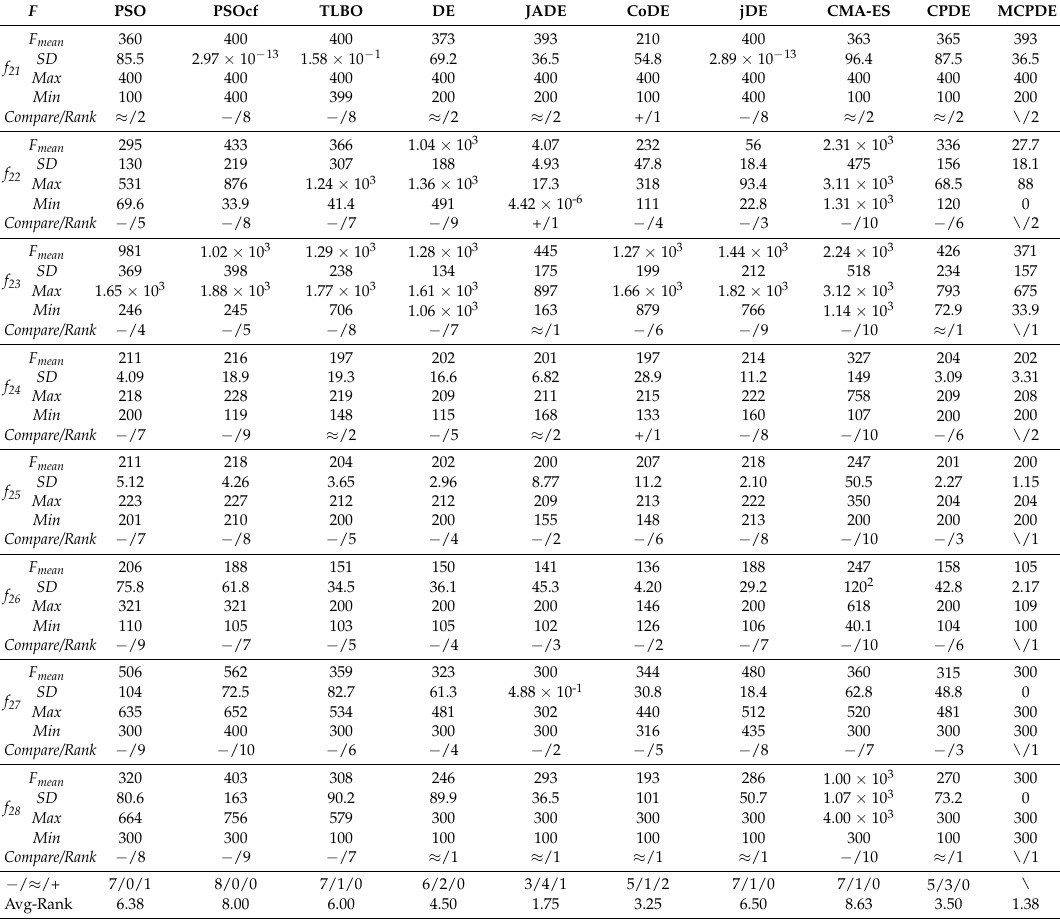
Table 5. Experimental results of PSO, PSOcf, TLBO, DE, JADE, CoDE, jDE, CMA-ES, CPDE and MCPDE over 30 independent runs on f 21 – f 28 test functions with 10 D .